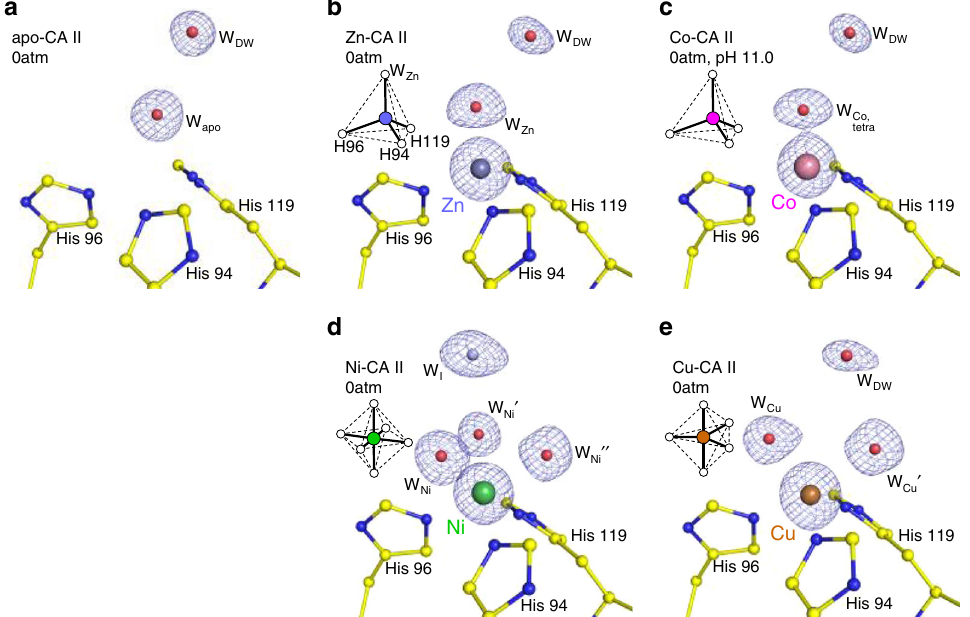
Fig. 2 Metal coordination geometry in CA II without CO 2 pressurization. a In apo-CA II, the metal binding site is vacant. b , c Zn- and Co-CA II show tetrahedral, d Ni-CA II octahedral, and e Cu-CA II trigonal bipyramidal coordination geometry. The electron density (2F o – F c , blue) is contoured at 2.2 σ . All structures were obtained at pH 7.8 except for ( c ) which is obtained at pH 11.0. The intermediate water (W I ) in ( d ) is colored in steel blue for clarity.